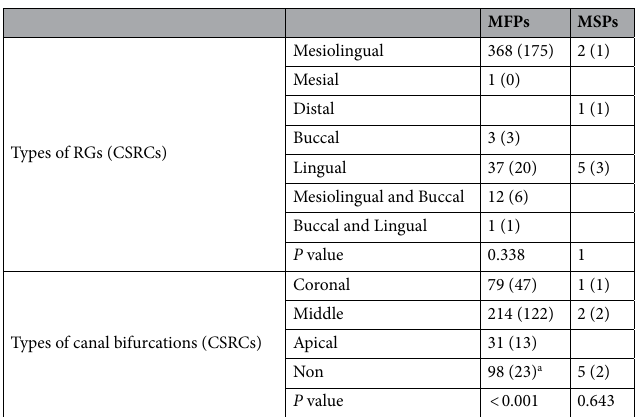
Table 3. The prevalence of CSRCs in different types of RGs and canal bifurcations. CSRCs: C-shaped root canals, RGs: radicular grooves, MFPs: mandibular first premolars, MSPs: mandibular second premolars. a The prevalence of CSRCs in Non-group was significantly lower than that in the other